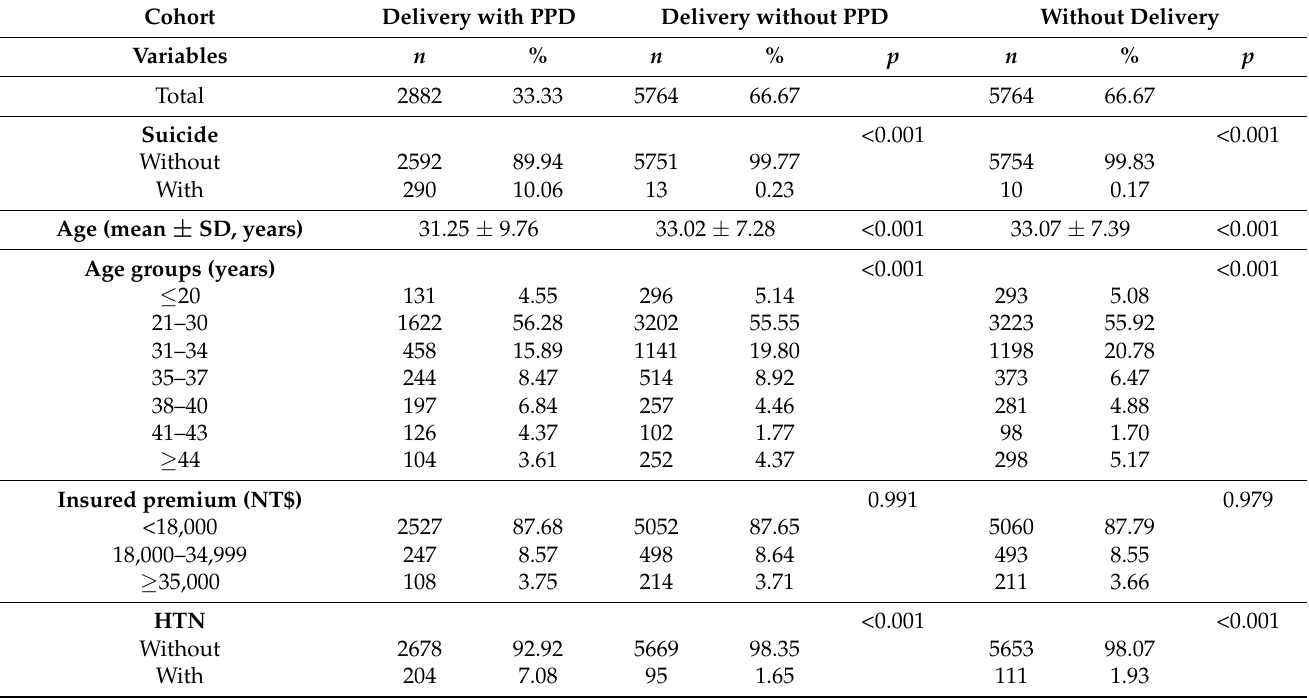
Table 1. Characteristics of study at the endpoint of